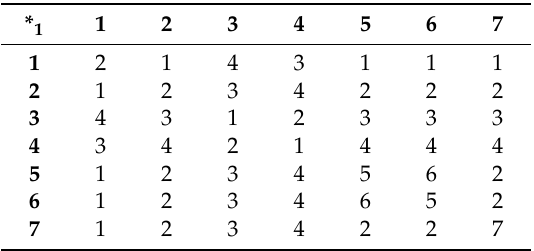
Table 9. The operation * 1 on commutative perfect NETG N 1 .